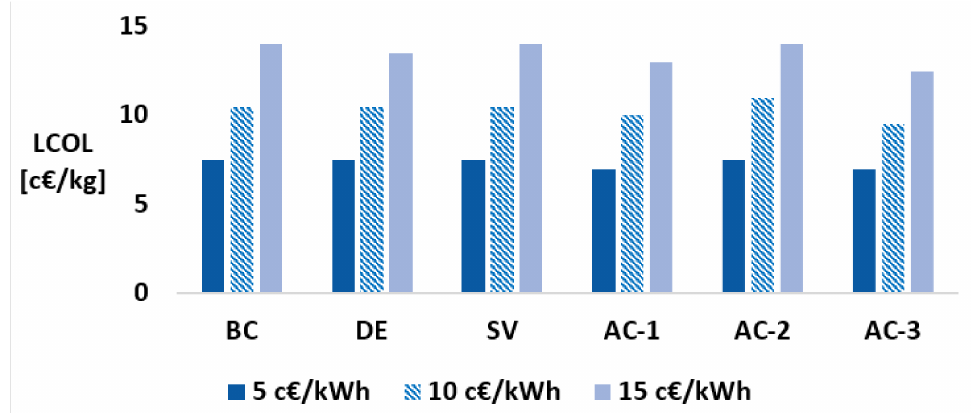
Figure 19. Levelized cost of liquefaction for the various cases. Different colors represent different price of